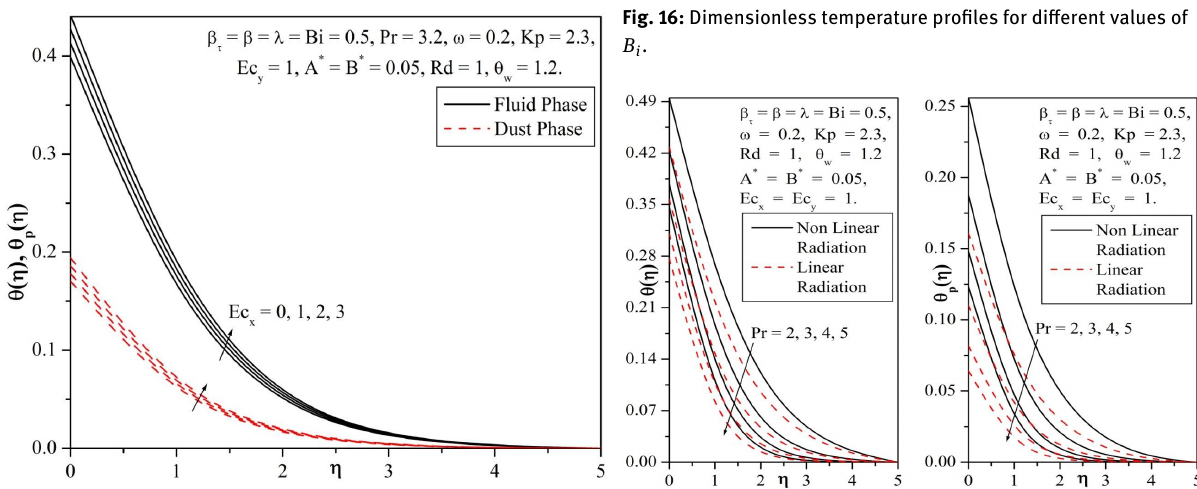
Fig. 14: Dimensionless temperature profiles for different values of Ec x .